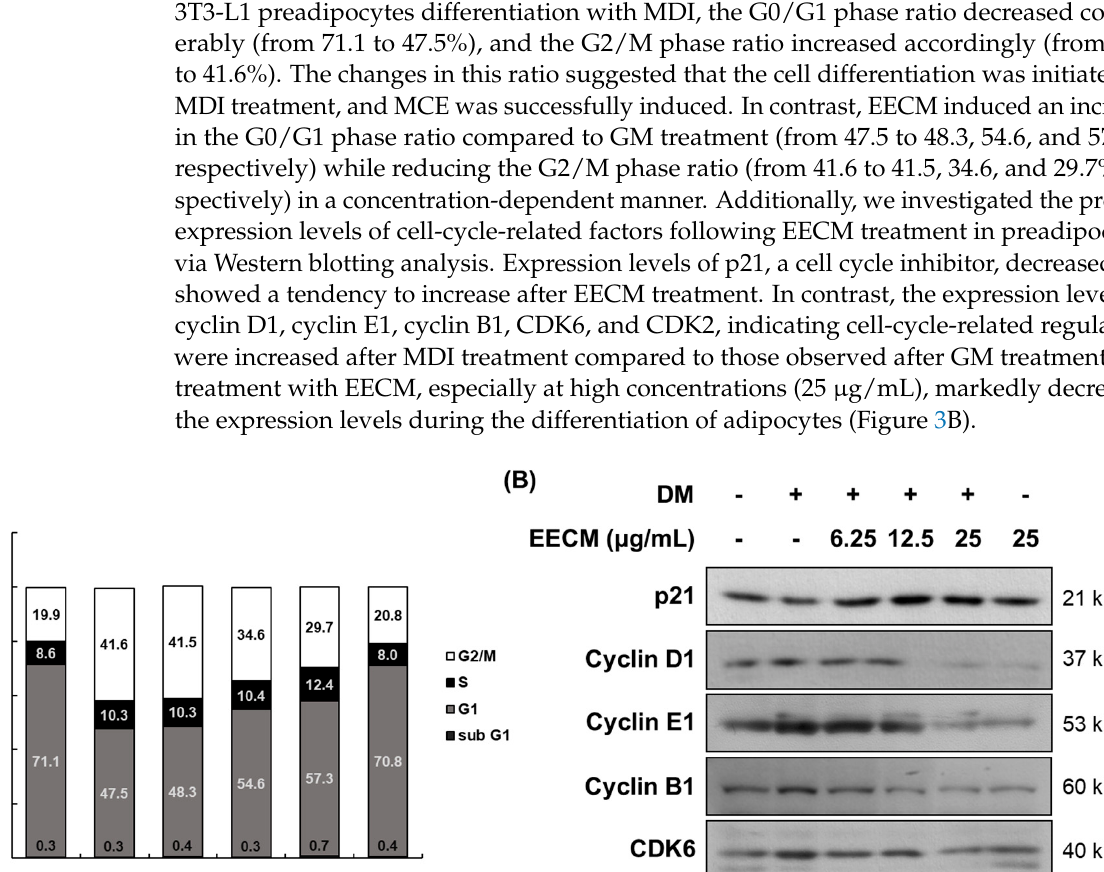
with EECM (6.25, 12.5, and 25 μ g/mL) for 24 h. ( A ) Cell cycle phase ratio and ( B ) cell-cycle-related proteins expression were measured via propidium iodide (PI) staining and Western blotting, respectively.